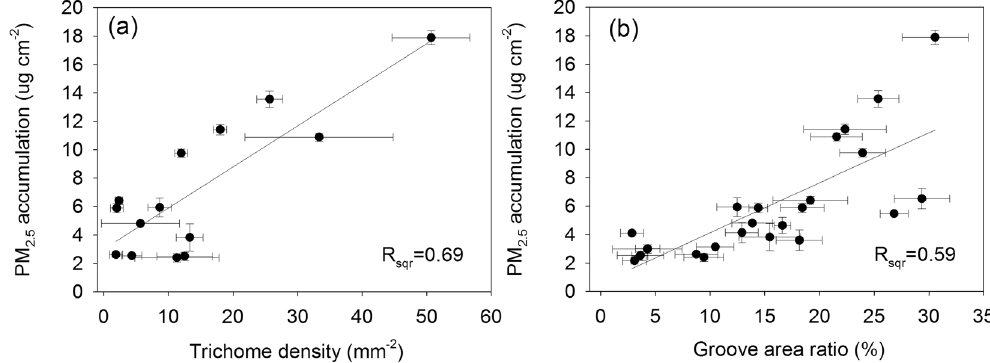
Figure 4. Relationship between foliar PM 2.5 accumulation and trichome density ( a ) and groove area ratio ( b ).